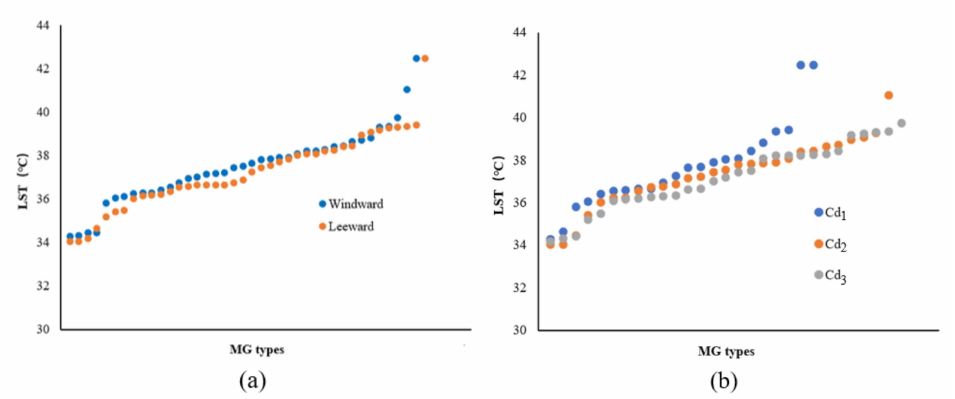
Figure 13. ( a ) Scatter plot of LST values corresponding to the MG types of green space in different locations (leeward or windward) in the Width-II river zone according to the increasing LST. ( b ) LST values corresponding to the MG types of the green space with different Cd grades in the Width-II river zone according to the increasing